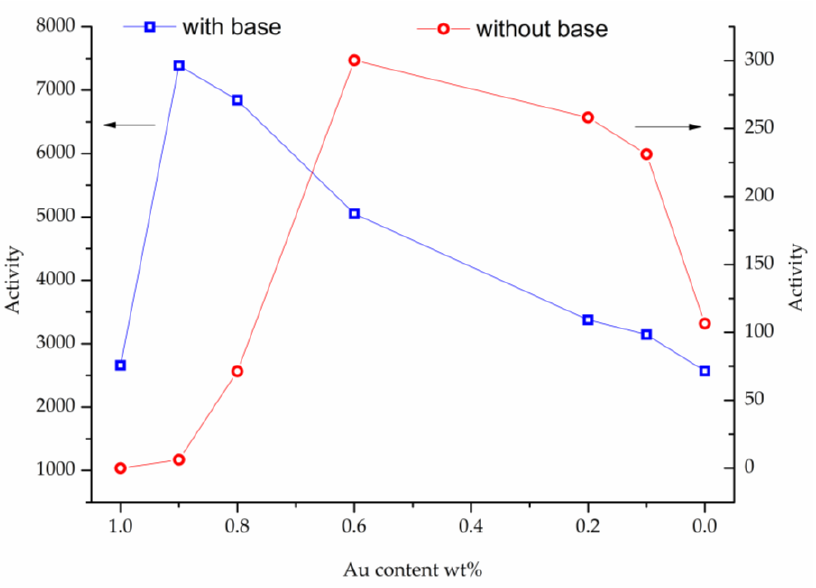
Figure 2. Influence of Au-Pt metal ratio on the initial activity in the glycerol oxidation in presence (blue) and absence (red) of a base.